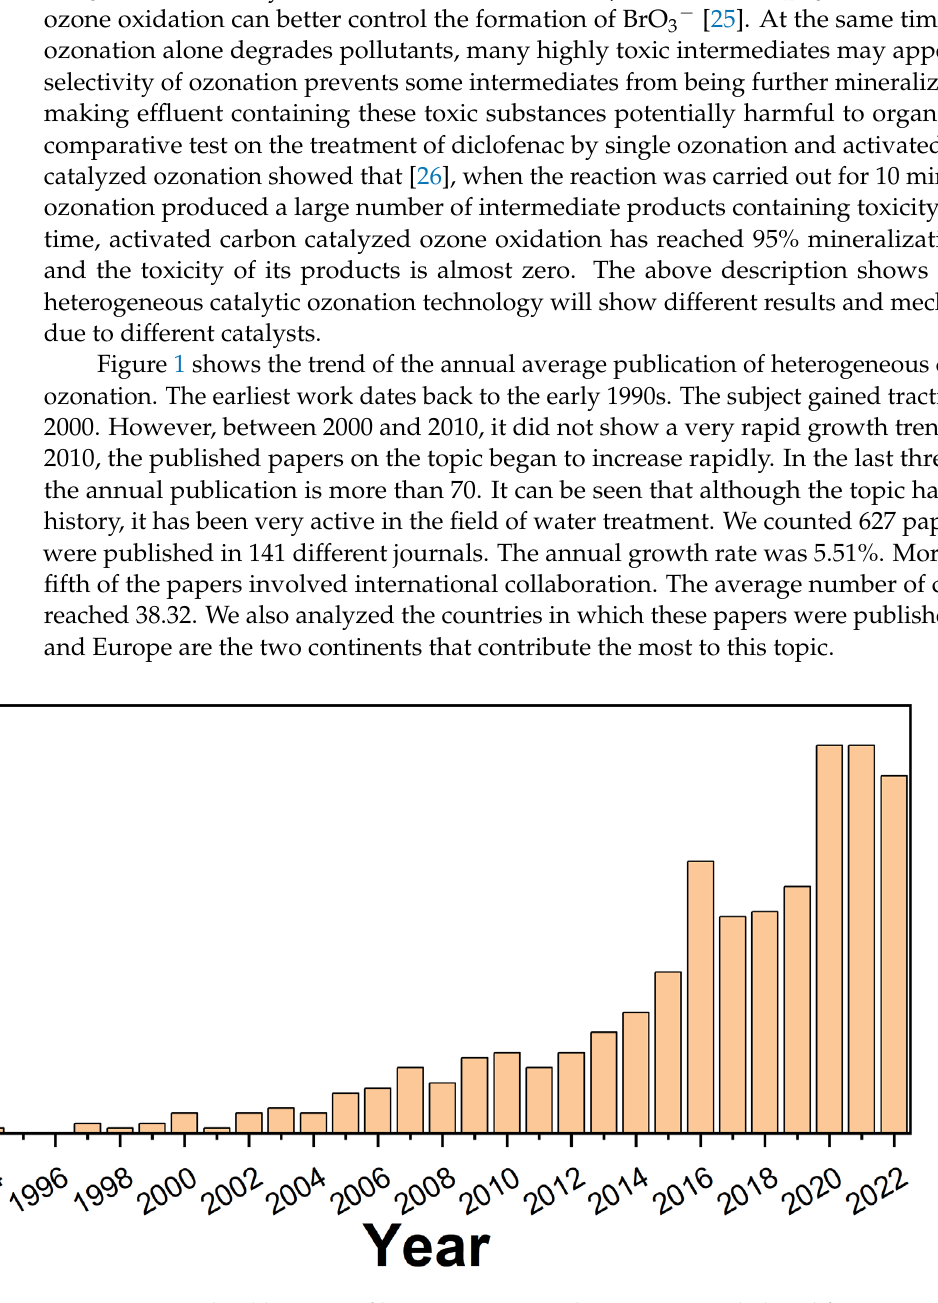
Figure 1. Annual publications of heterogeneous catalytic ozonation deduced from WOS database (Science Citation Index Expanded).